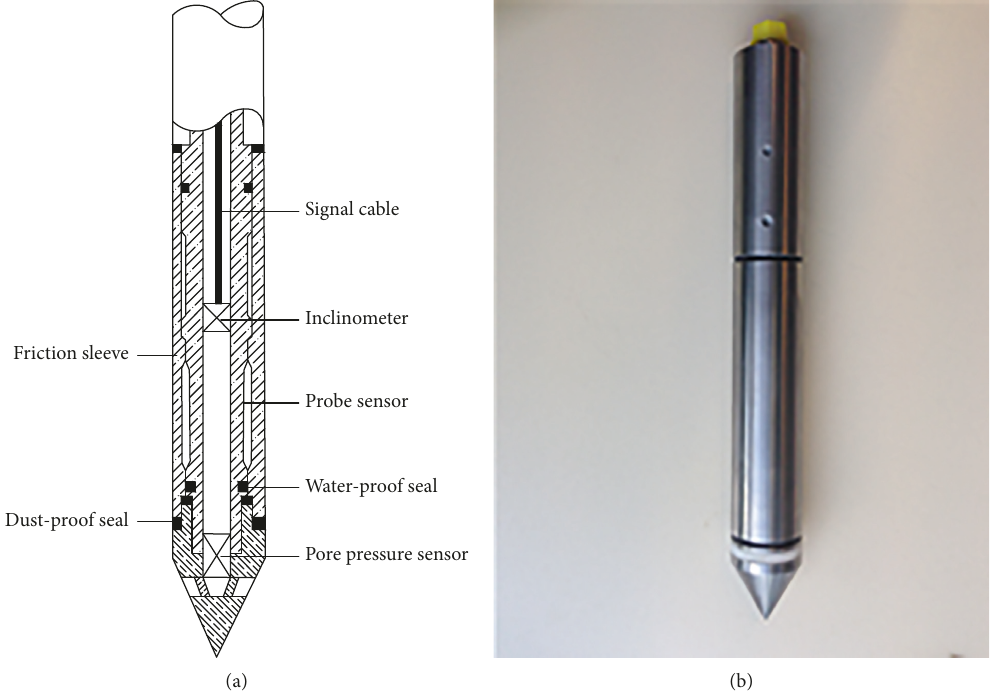
Figure 3: Pore pressure probe of the Wison-APB downhole CPT.